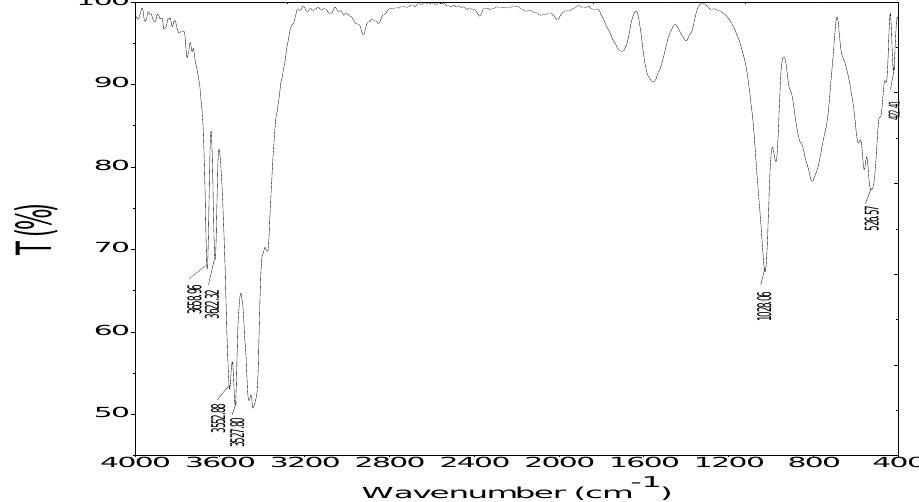
Figure 3. The FT-IR spectra of synthesized nano-aluminum hydroxide nanoparticles.